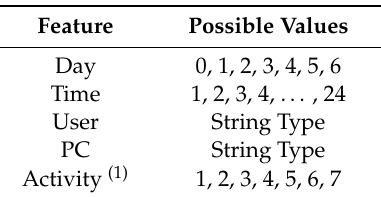
Table 2. Encoded features at pre-processing phase.